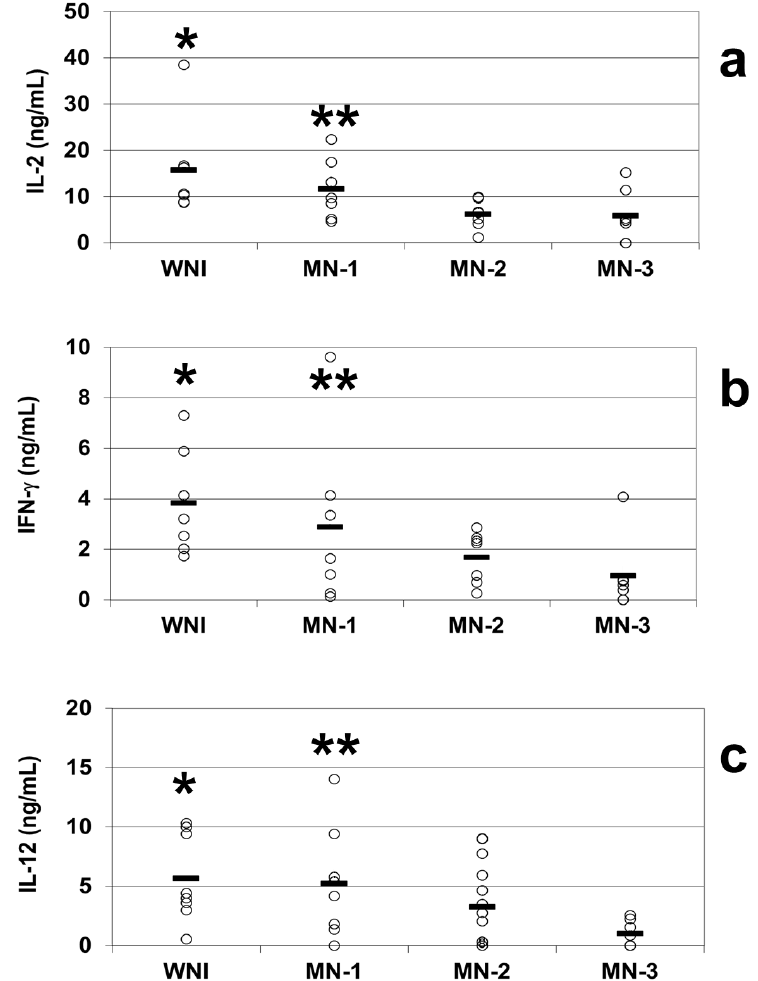
Figure 3. Plasma cytokine levels from well-nourished and malnourished children. Circulating IL-2 ( a ), IFN-γ ( b ) and IL-12 ( c ) levels were obtained by ELISA. The plasma was obtained from peripheral blood samples of WNI, MN-1, MN-2 and MN-3. The data are presented as the mean ± standard error. ( a ) Plasma IL-2 levels. Significant difference: * WNI vs. MN-2 and MN-3; ** MN-1 vs. MN-3; p < 0.05; ( b ) Plasma IFN-γ levels. Significant differences: * WNI vs. MN-2 and MN-3, ** MN-1 vs. MN-3, p < 0.05; ( c ) Plasma IL-12 levels. Significant difference: * WNI vs. MN-2 and MN-3; ** MN-1 vs. MN-3; p <